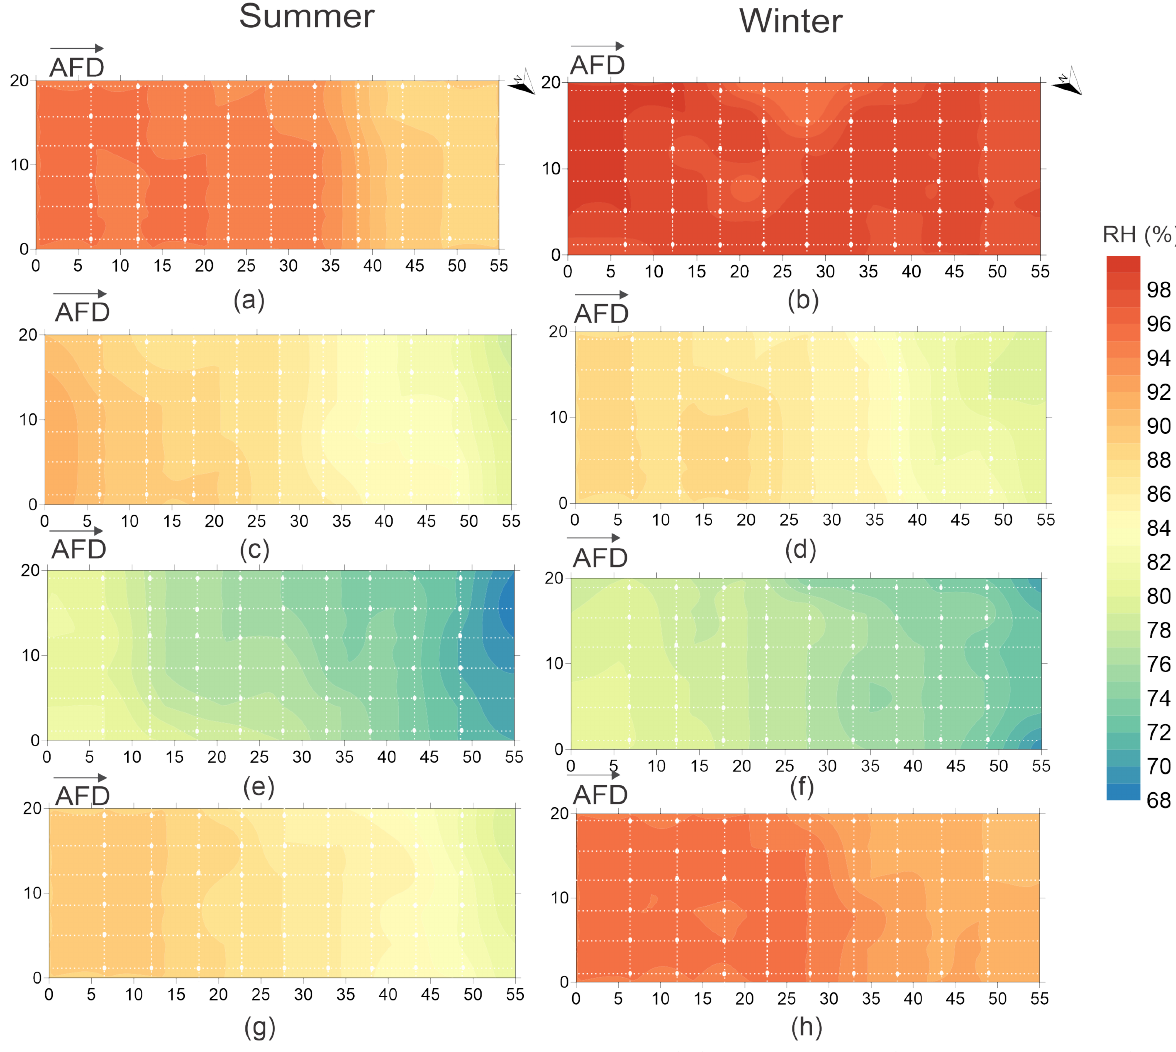
Figure 6. Spatial distribution of the variable air relative humidity (%), during the dawn (00:00a.m. to 05:00a.m.), morning (06:00a.m. to 11:00a.m.), afternoon (12:00a.m. to 05:00 p.m.) and night (06:00p.m. to 11:00p.m.) inside the compost bedded pack barn (CBP) during the summer and winter experimental